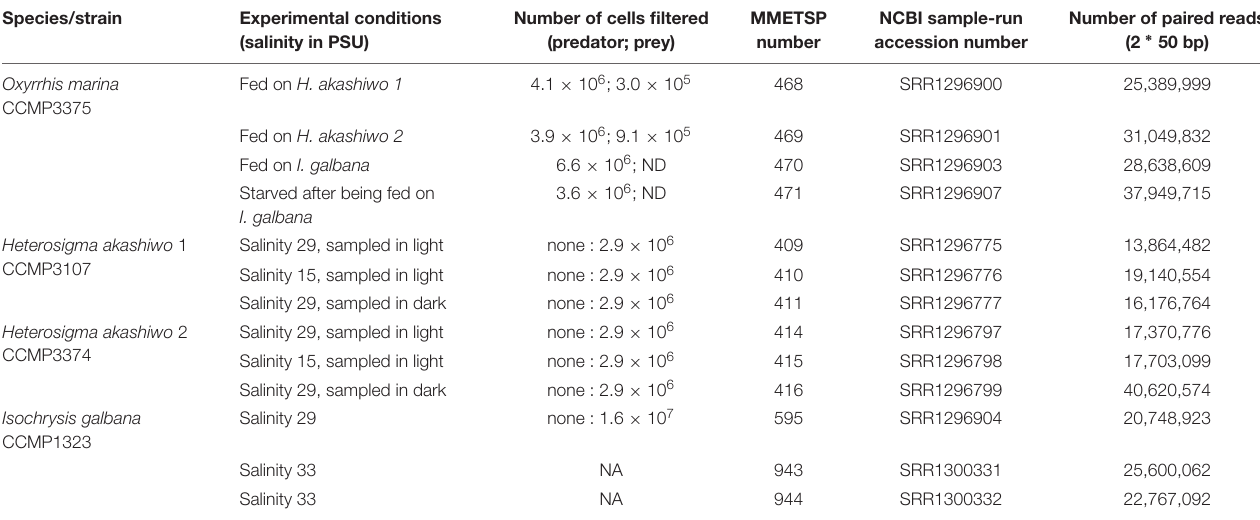
TABLE 1 | Experimental summary including strain identification, experimental conditions, number of cells filtered, transcriptome identification numbers for both the Marine Microbial Eukaryote Transcriptome Sequencing Project (MMETSP) and the National Center for Biotechnology Information (NCBI) sequence read archive and the number of paired reads in each transcriptome.